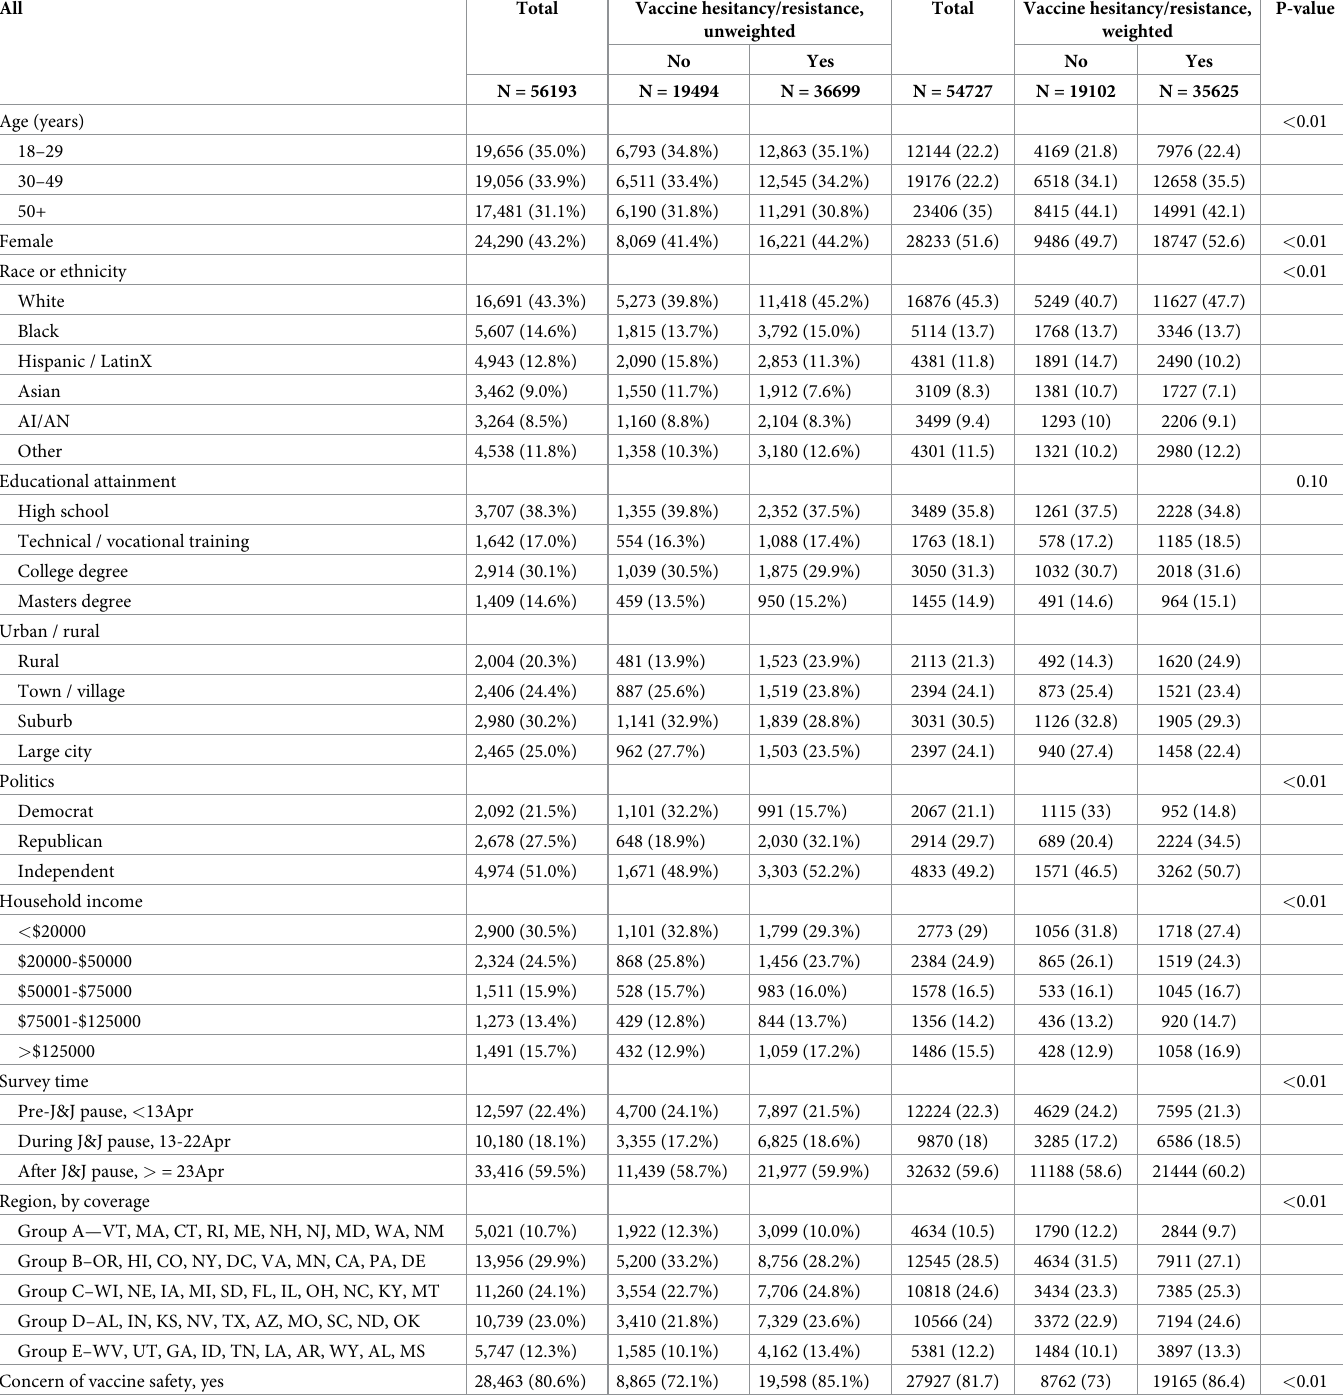
Table 1. Sociodemographic characteristics by vaccine hesitancy status (hesitant/against versus not) (versus not) among unvaccinated respondents (n = 56,193, unweighted), unweighted/weighted.